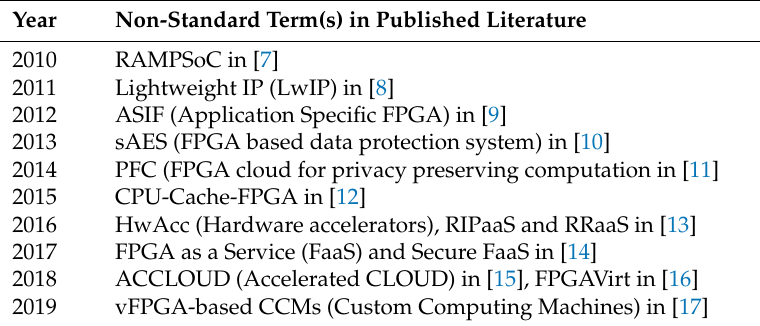
Table 1. Non-Standard Nomenclature Present in